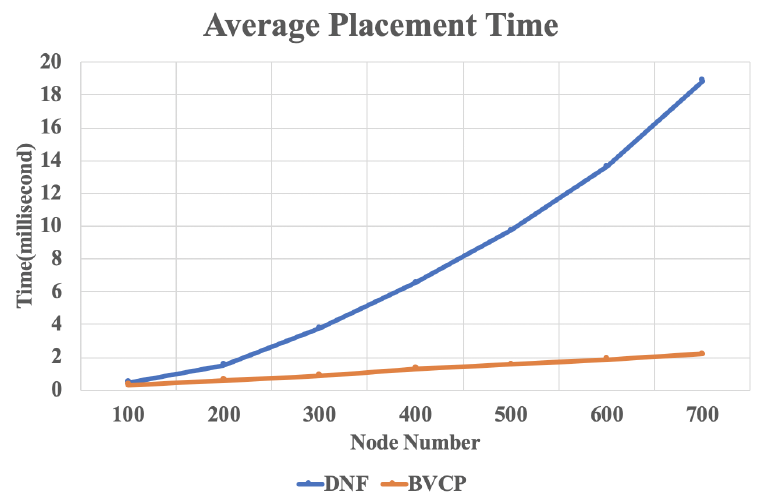
Figure 8. The result of average placement